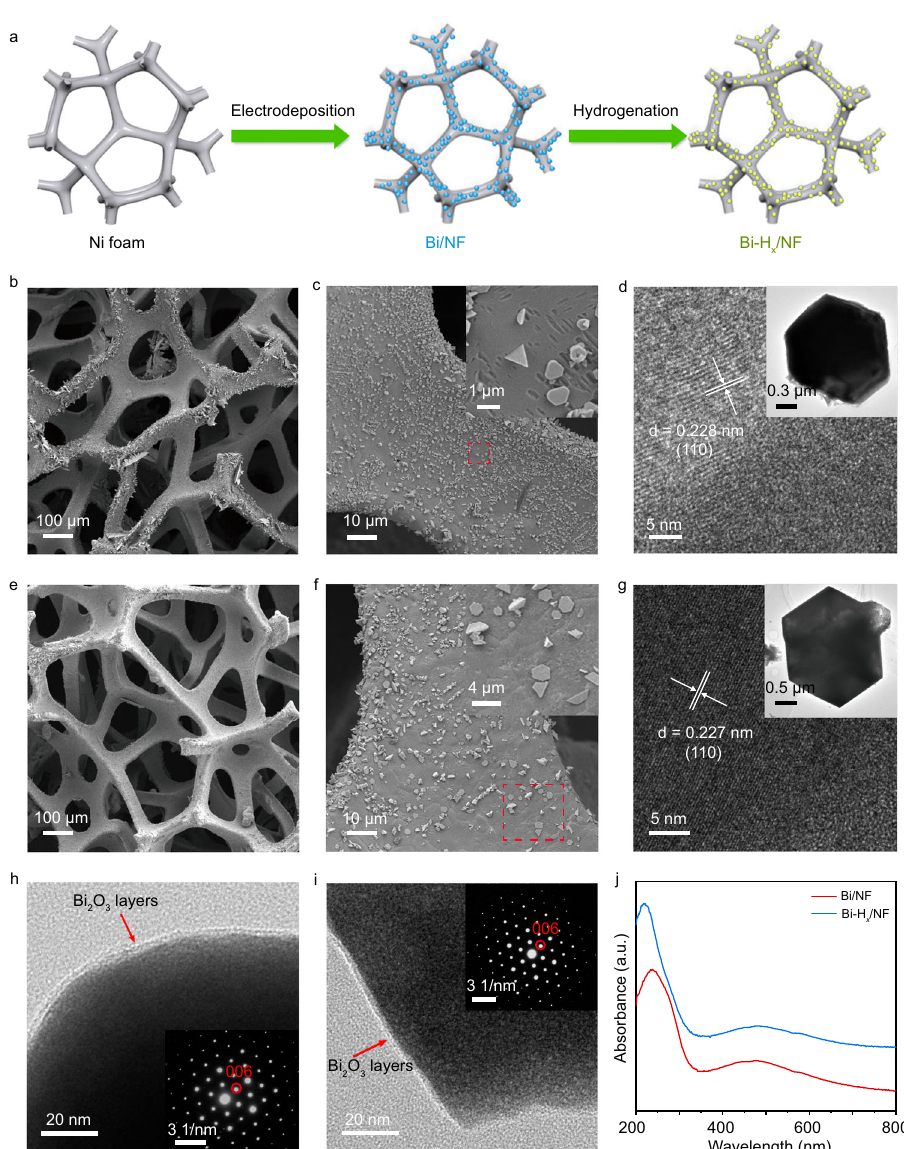
Fig. 3 Morphologies, microstructures, and light absorption properties of the samples. a Schematic illustration of the synthesis process of Bi-H x /NF. SEM images of ( b , c ) Bi/NF and ( e , f ) Bi-H x /NF. The insets in ( c ) and ( f ) are enlarged views of the corresponding SEM images marked in red squares. d , g HRTEM images of Bi/NF and Bi-H x /NF. The insets in ( d ) and ( g ) are the TEM images of Bi/NF and Bi-H x /NF sheets, respectively. h , i TEM images of the edges of Bi/NF and Bi-H x /NF sheets for showing the formation of amorphous layers. The insets in ( h ) and ( i ) are the SEAD patterns of Bi/NF and Bi-H x / NF. j UV – visible absorption spectra of Bi/NF and Bi-H x